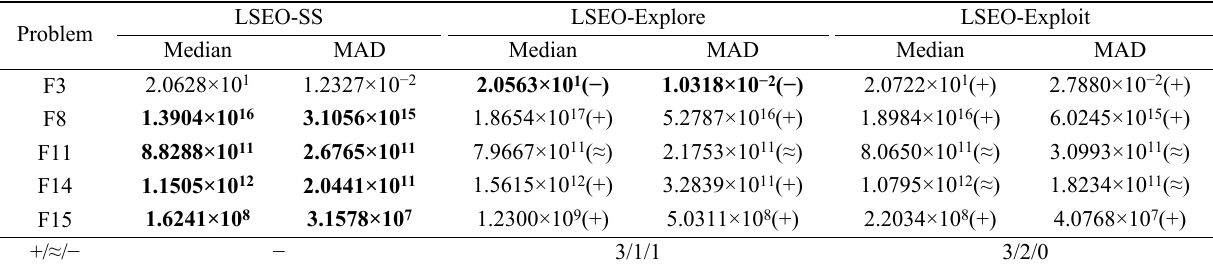
Table 3 Statistical results of the optimal objective values, given in median and median absolute deviation (MAD), of LSEOSS, LSEO-Explore, and LSEO-Exploit, on F3, F8, F11, F14, and F15 problems.